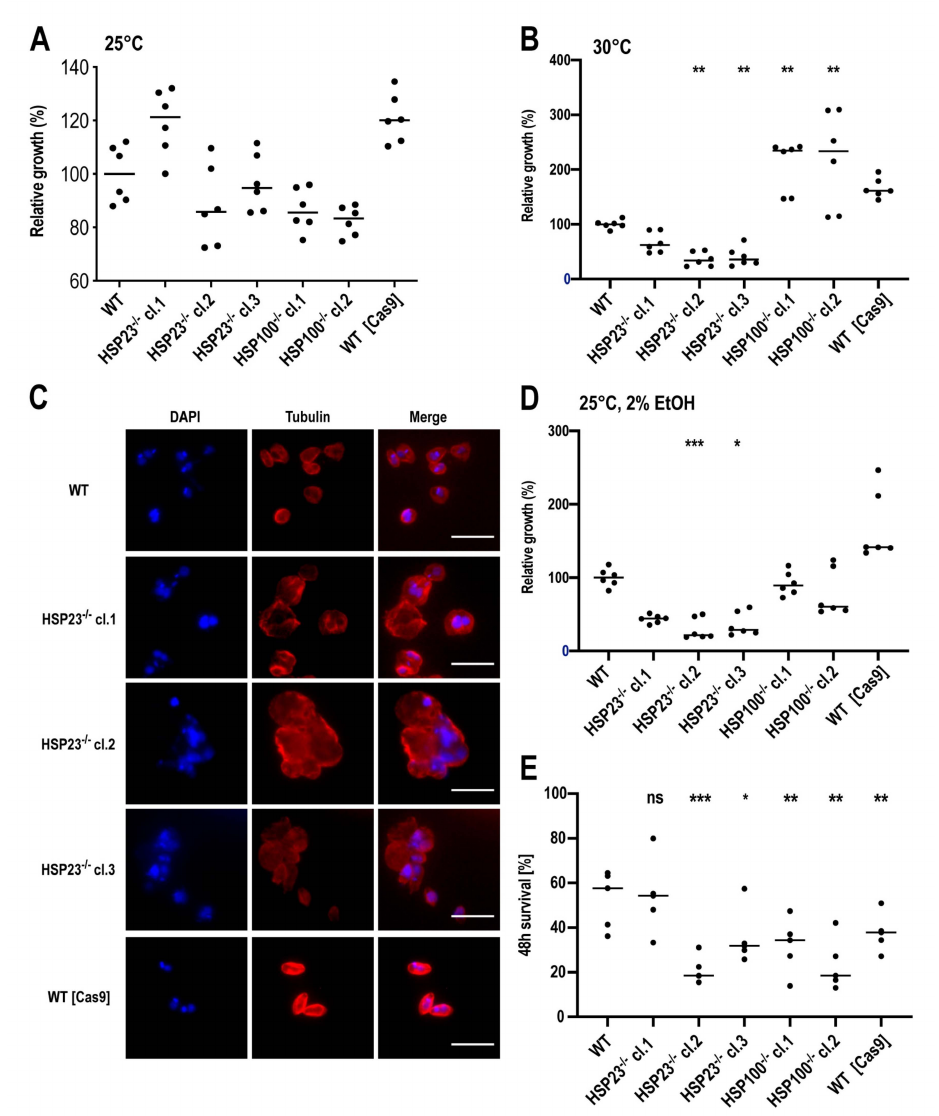
Figure 4. Phenotypic analyses of L. braziliensis HSP23 – / – and HSP100 – / – clones. For growth curves, promastigotes of WT, WT (Cas9), HSP23 – / – clones, and HSP100 – / – clones were seeded at a density of 1 × 10 6 parasites / mL into 5 ml of complete M199 medium and grown for 4 days. Cell density was measured on day 4 and is shown as a percentage of WT cell density (set at 100%). Parasites were grown at 25 ◦ C ( A ) and 30 ◦ C ( B ). The HSP23 – / – clones incubated for 4 days at 30 ◦ C were also stained with mouse anti-tubulin antibody (1 / 4000) and DAPI (1 / 50) ( C ). Images were taken on an EVOS FL Auto Cell Imaging System and processed using the ImageJ Software (https: // fiji.sc). Scale bar: 10 µ m. Additional cultures were grown at 25 ◦ C and pH 7.4 with the addition of 2% ethanol ( D ). The horizontal black lines in panels A, B, and D indicate the median of 6 biological samples from 3 separate experiments. Significance was tested using the Kruskal–Wallis test; * p < 0.05, ** p < 0.01, *** p < 0.001. ( E ) Primary mouse bone-marrow-derived macrophages were di ff erentiated and infected with stationary-phase promastigotes of WT, WT [Cas9], HSP23 – / – clones, and HSP100 – / – clones at a MOI of 1:8 (macrophage-to-parasite ratio). After 4 h, free parasites were washed away and the infected macrophage cultures were further incubated at 34 ◦ C under 5% CO 2 for 44 h. Genomic DNA from Leishmania -infected macrophages was isolated at 4.5 h and at 48 h post-infection, and parasite load was determined by TaqMan qPCR quantifying parasite actin gene DNA relative to host macrophage actin gene DNA. Shown is intracellular parasite survival [%] after 48 h, with the bar indicating the median of n = 5. Ratio-paired, one-sided Student’s t -test: * p < 0.05, ** p < 0.01, *** p < 0.001 between data pairs. ns = not